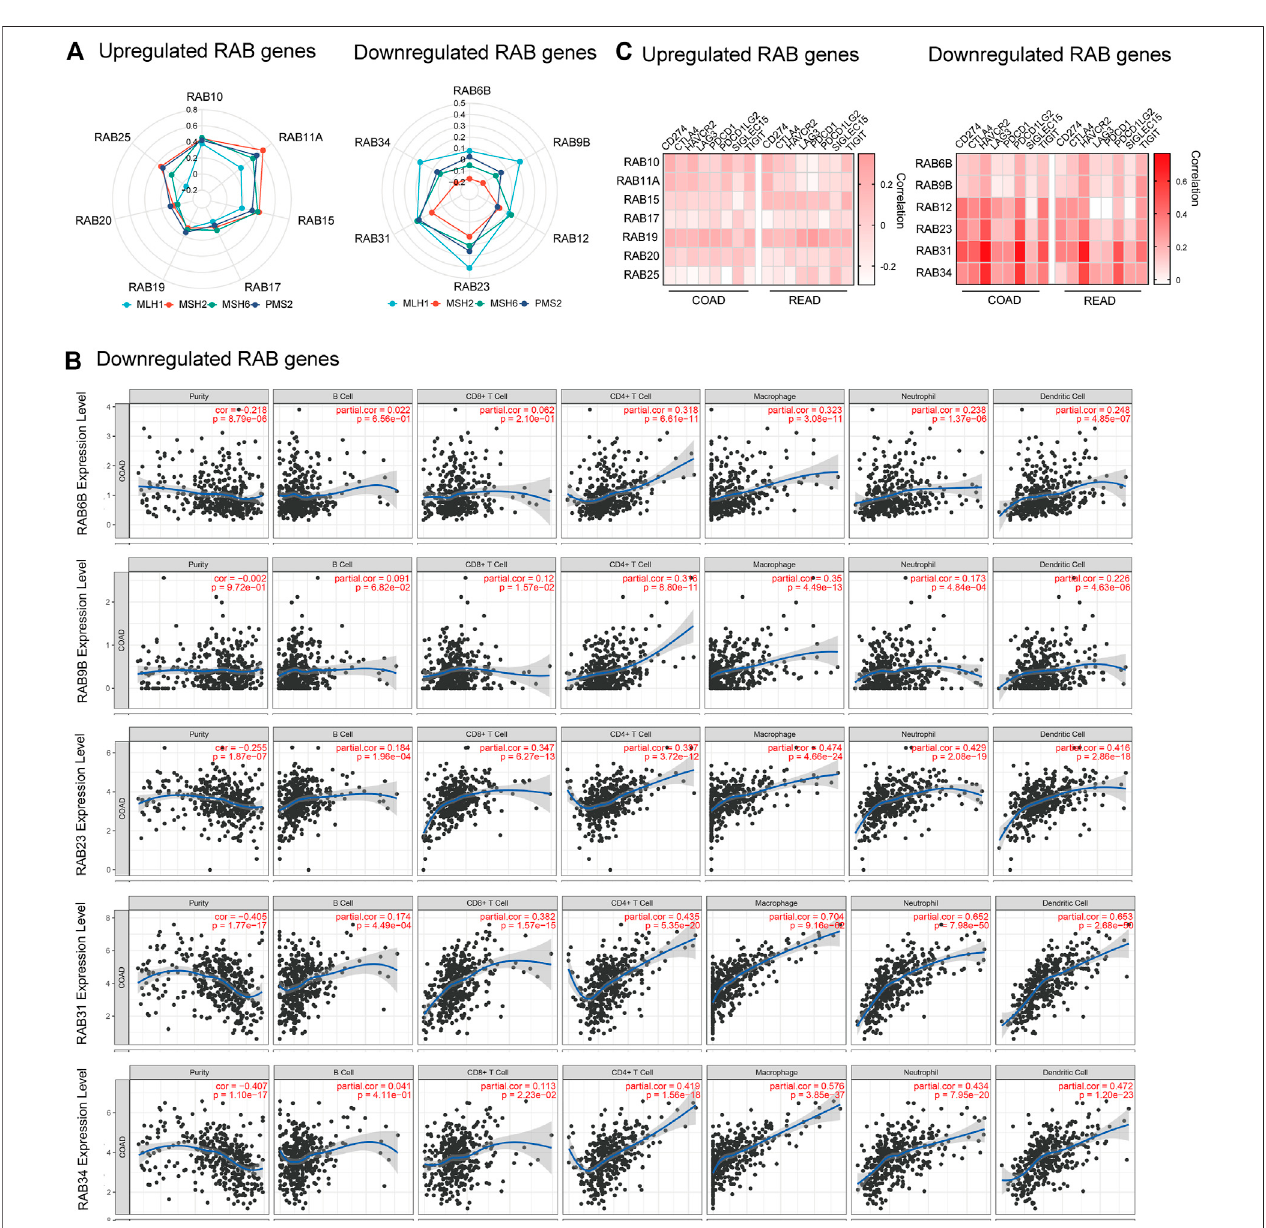
FIGURE 4 | Correlation between RABs expression and immunotherapy biomarkers in CRC patients. (A) Correlation between the expression of RABs and MMR genes( p -valueofeach pathway wereshown inSupplementaryTablesS5 – 6). (B) CorrelationbetweenRABsandimmunecells in fi ltration levels inCOAD. (C) Correlation between the expression of RABs and immune checkpoint genes. Spearman ’ s correlation coef fi cients were shown above the bar graphs.